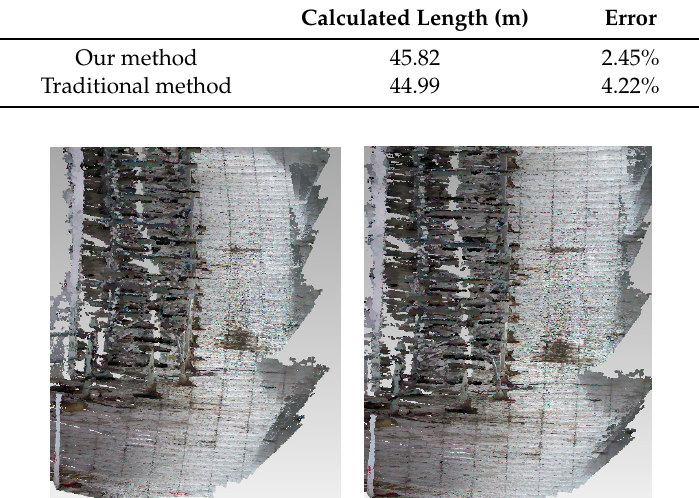
Table 3. Localization results of experiment I with a ground truth length of 46.97 m.